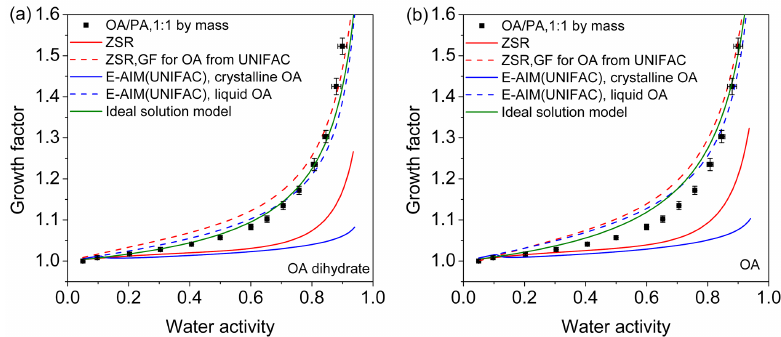
Figure 9. Hygroscopic growth factors of aerosols consisting of oxalic acid and phthalic acid (OA / PA) at a mass ratio of 1:1 as a function of water activity. Initial particle diameter is about 100nm. Predictions from the ZSR, E-AIM (UNIFAC), and ideal solution model are also included, assuming (a) oxalic acid dihydrate and (b) anhydrous oxalic acid in the initial particles under dry conditions. The dashed lines are calculated based on liquid oxalic acid (OA) assumption. The uncertainty in our measured growth factors is within 0.02.